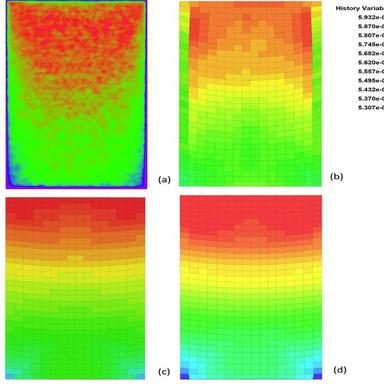
Relative density d (compared to sintered density) for a middle cut of the cylinder also used for reverse engineering. (a) is results from neutron measurements, (b) FEM with the currently determined material parameters, (c) parameters according to Brandt and Nilsson and (d) according to Andersson et al..